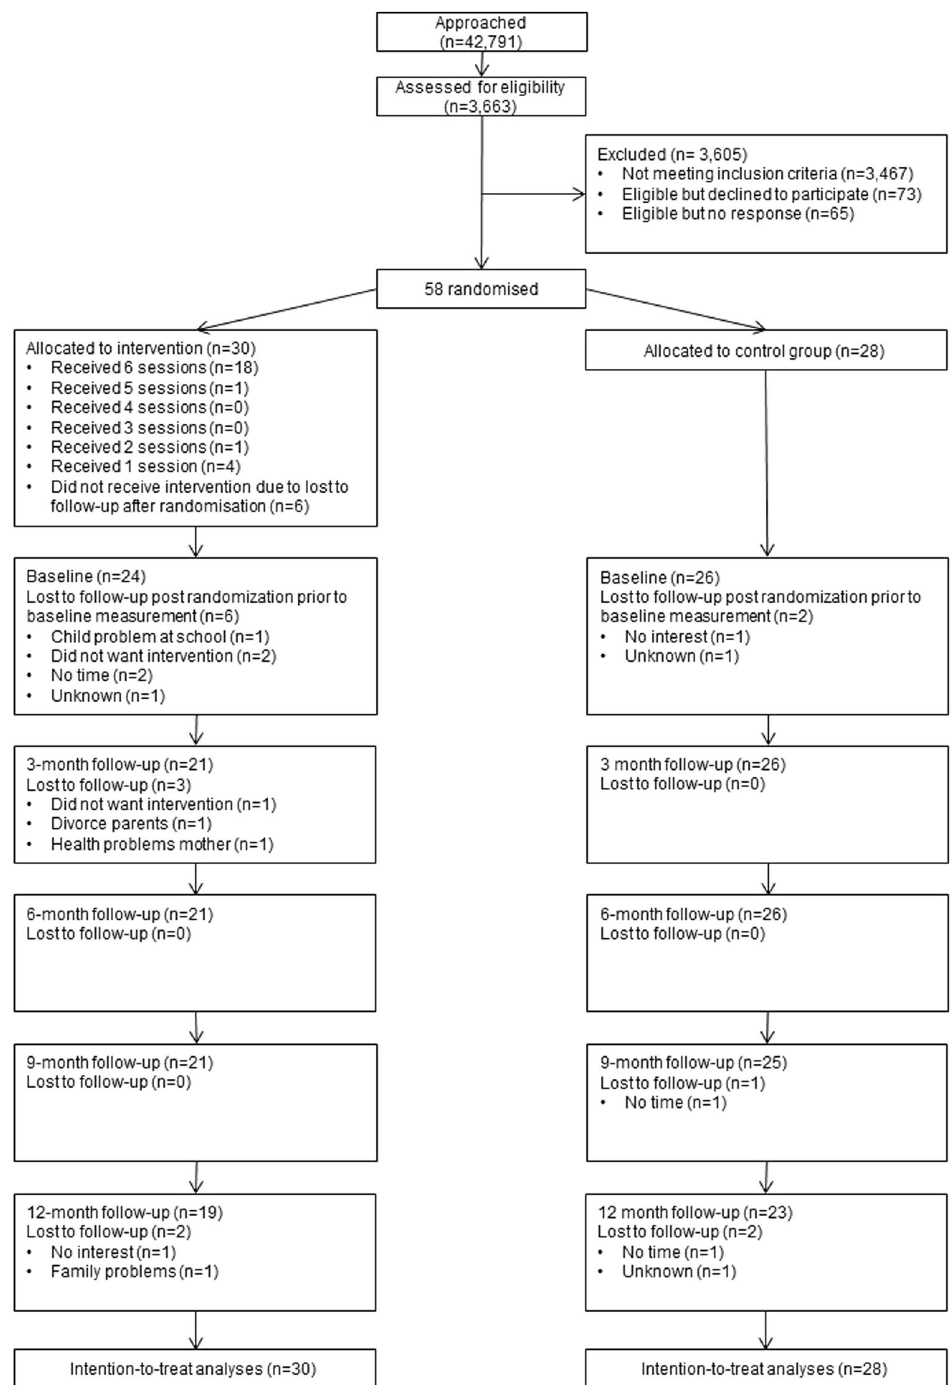
Figure 1. Flow Chart. Flow chart randomised controlled